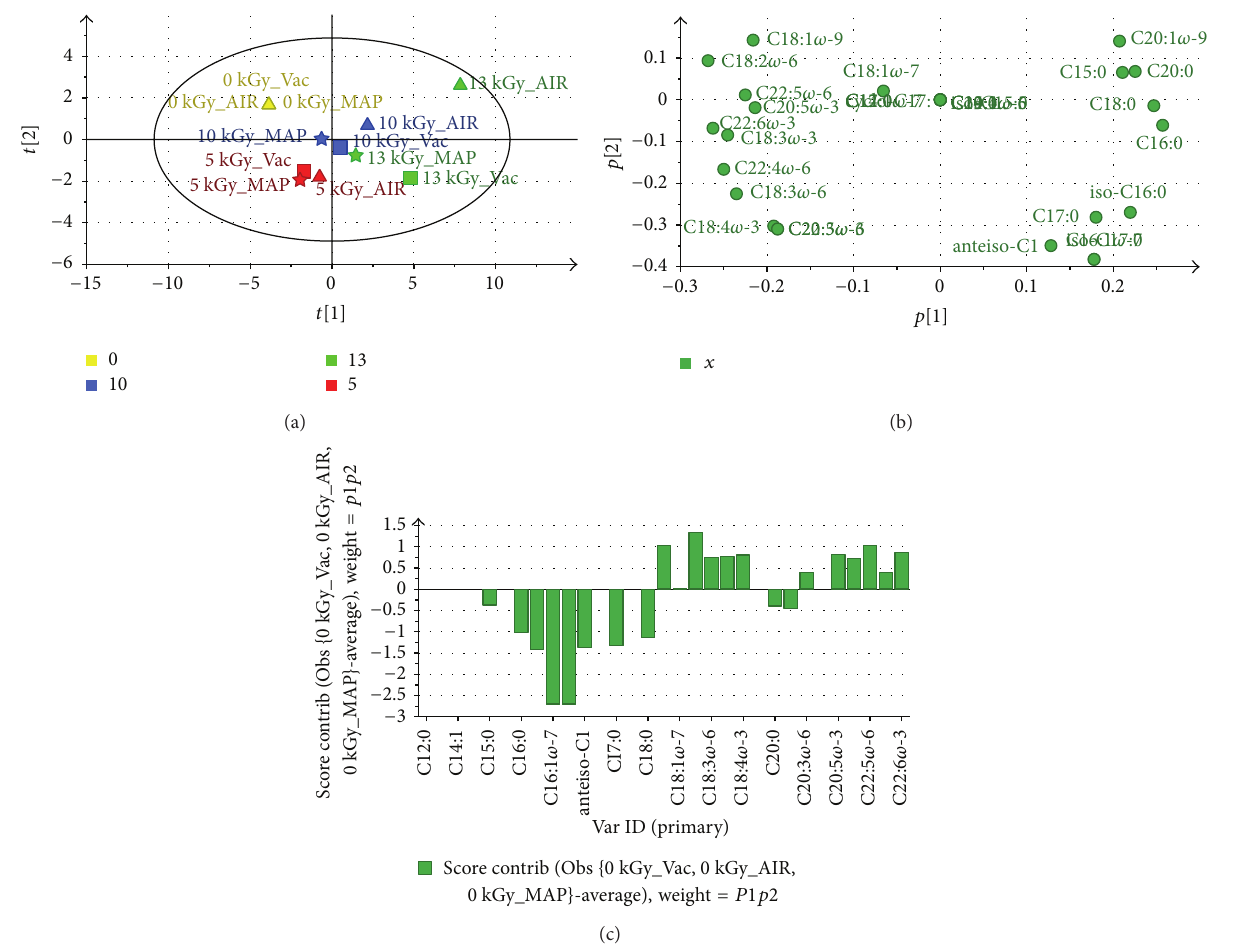
Figure 1: (a) PCA model of GC-FID data scaled to Unit Variance (UV scaling); 𝐴 = 2 , 𝑅 2 𝑋 1,2 ( of MAP, air, and vacuum packages are denoted by a star, triangle, and box, respectively. Yellow, red, blue, and green colors correspond to 0, 5, 10, and 13 kGy, respectively, as also denoted by the labels. Only the mean values of six different measurements per irradiation dose and packaging are presented. (b) Loading plot. (c) Contribution plot indicating fatty acids responsible for the discrimination of nonirradiated control samples (positive values) with the irradiated ones (negative